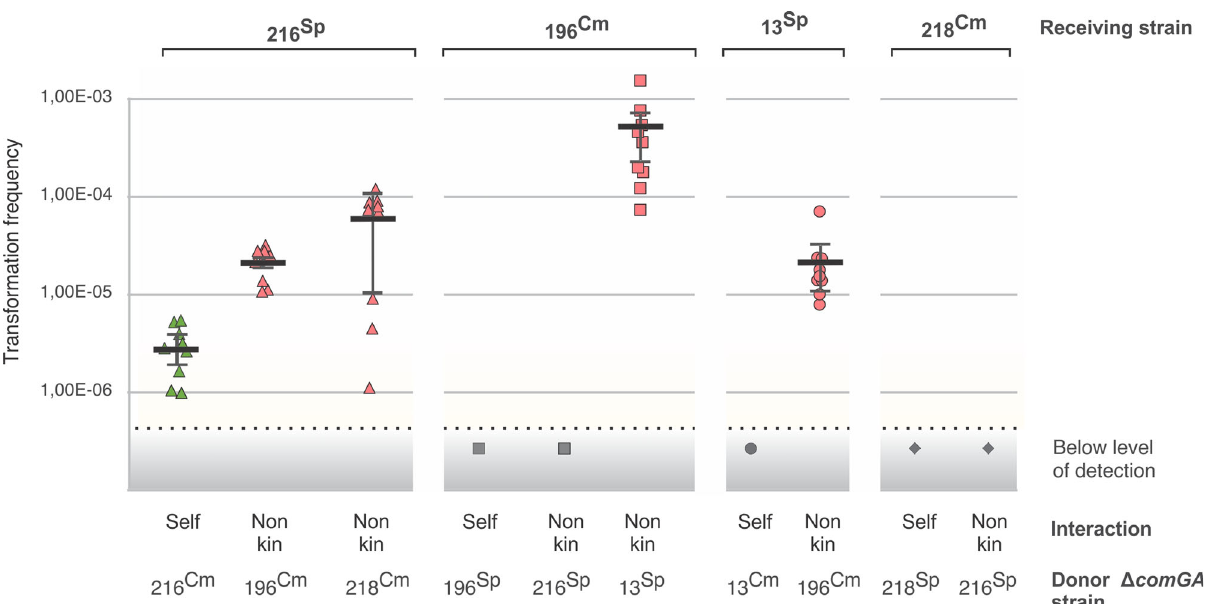
Fig. 2 Transformation frequencies of wt B. subtilis DNA receiving strains paired with donor Δ comGA mutants. Transformation frequency was measured as the proportion of double transformants at swarm boundaries. Self-interactions are shown in green, non-kin interactions in red and transformation frequencies below level of detection in grey colour. Data are presented as mean values ± SD and error bars represent SD of the mean values ( n = 3 biologically independent experiments, each n performed in three technical replicates (9 data points). Strains are depicted by different shapes: PS-216 triangle, PS-196 square, PS-13 circle and PS-218 a diamond. For strain abbreviations see Table 2 and for strain combinations see Supplementary Table